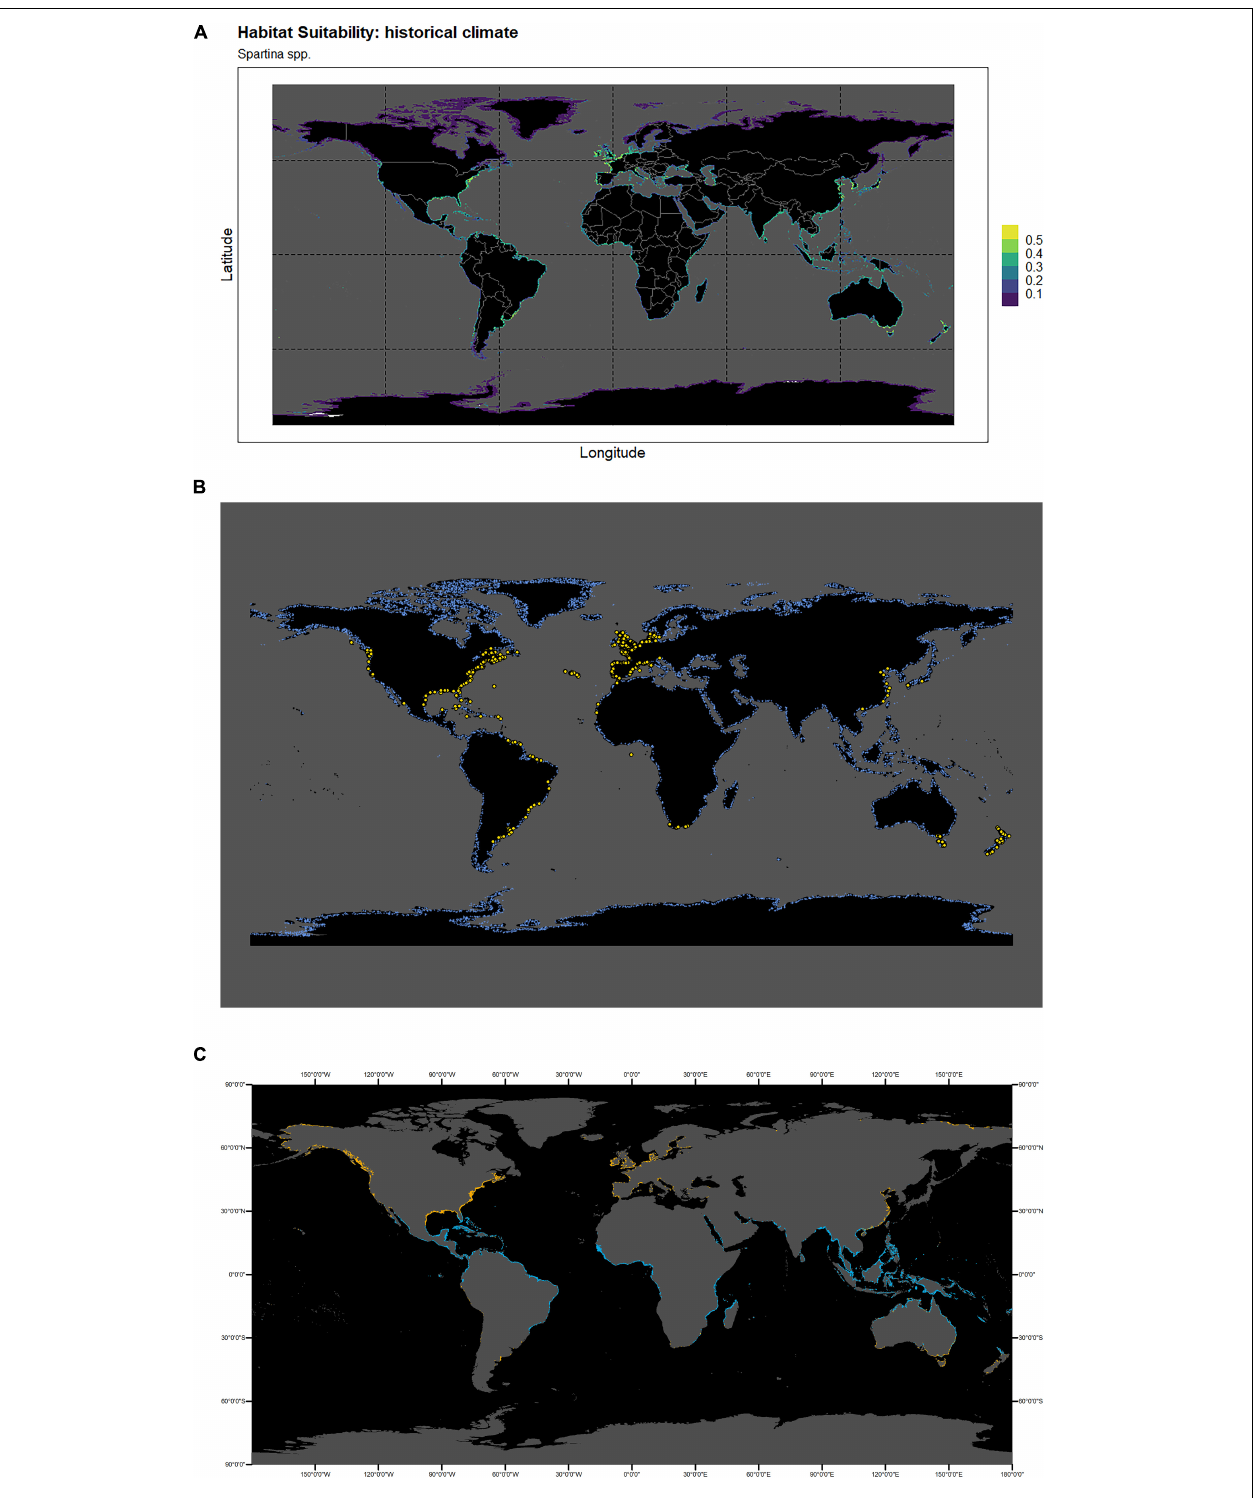
FIGURE 1 | (A) Habitat suitability map for the historical climate conditions for the genus Spartina ; and (B) Distribution of presence points of Spartina spp. in geographical space (blue), plotted from the data compiled from GBIF and the surveyed literature, and the randomly generated background pseudo-absences for the whole-genus analysis (white). (C) Worldwide distribution of saltmarshes (COR) and mangroves (COR), plotted in ArcMap v10.7.1., using two polygon layers obtained from Ocean Data Viewer (https://data.unep-wcmc.org) from (1) the Global Distribution of Saltmarshes (Mcowen et al., 2017), and (2) the World Atlas of Mangroves (Spalding et al.,